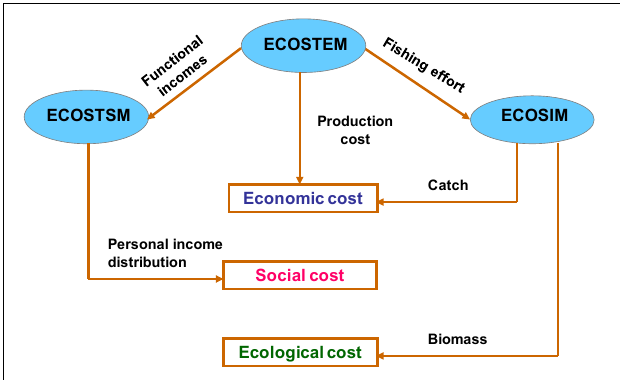
FIGURE 2 | The linkages of social, economic and ecological models for cost calculation.